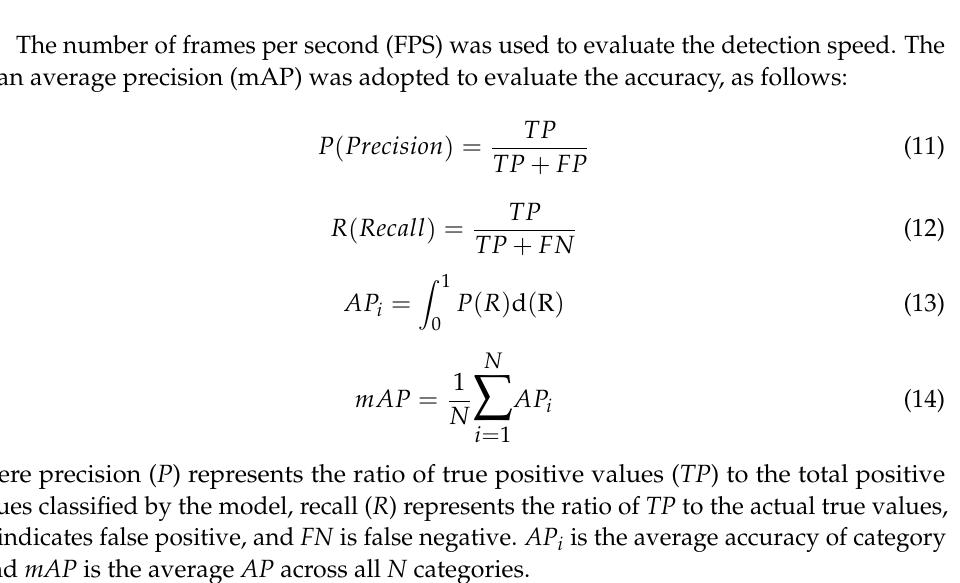
Figure 9. Mosaic image augmentation.